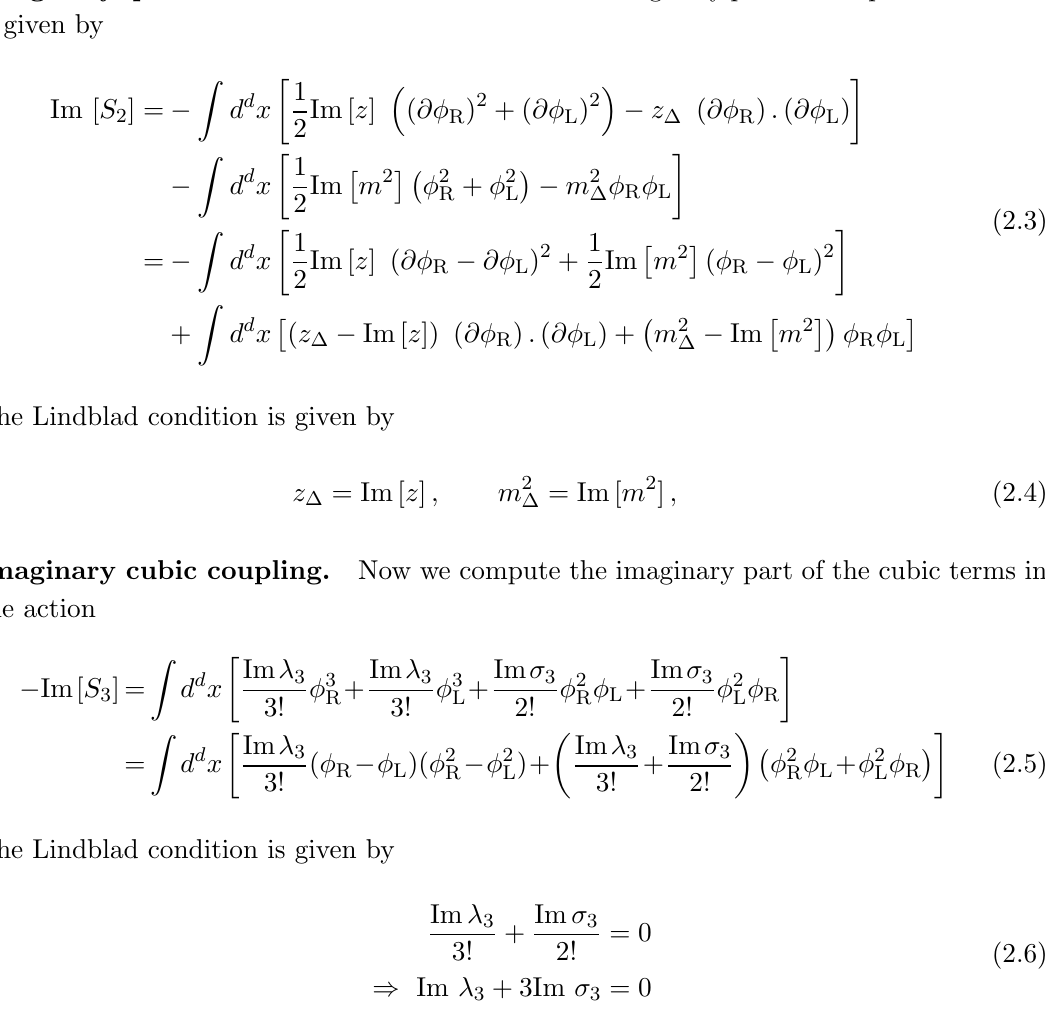
Imaginary quadratic terms of the